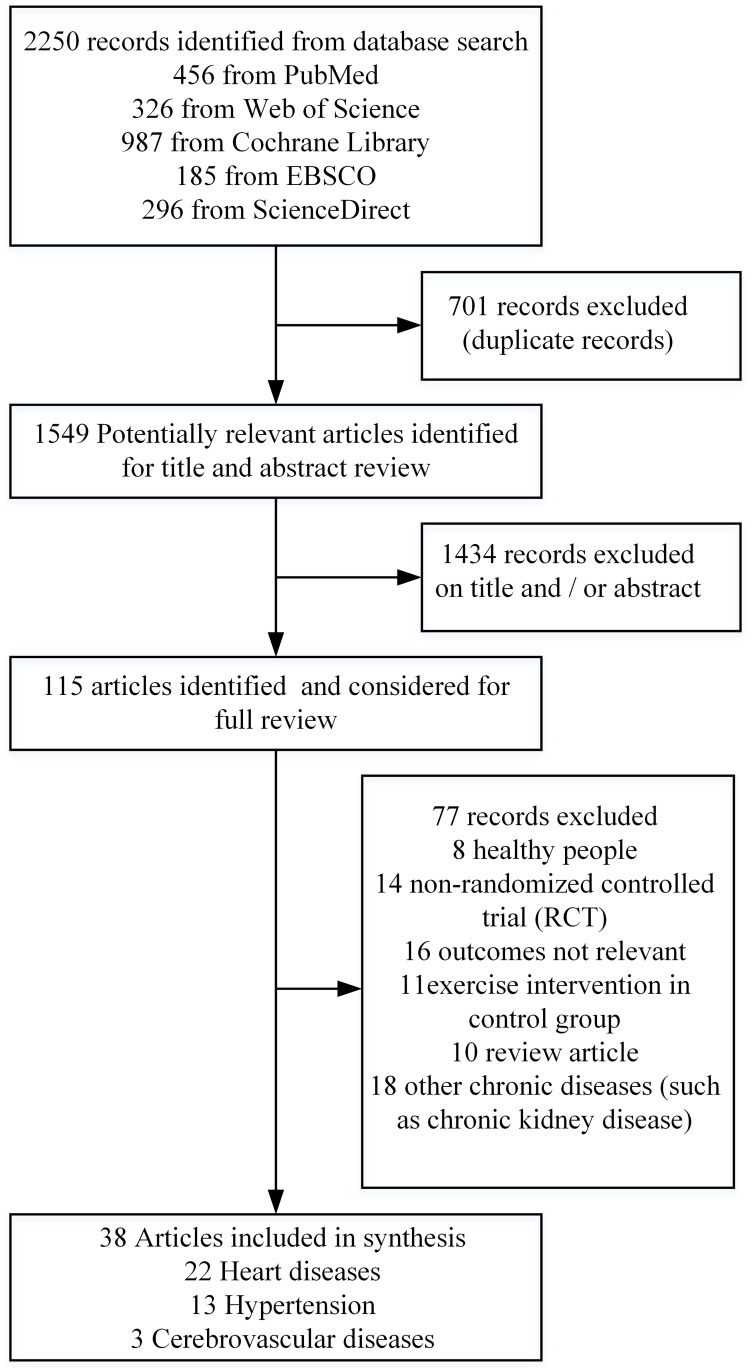
Flow chart of the study selection procedure.